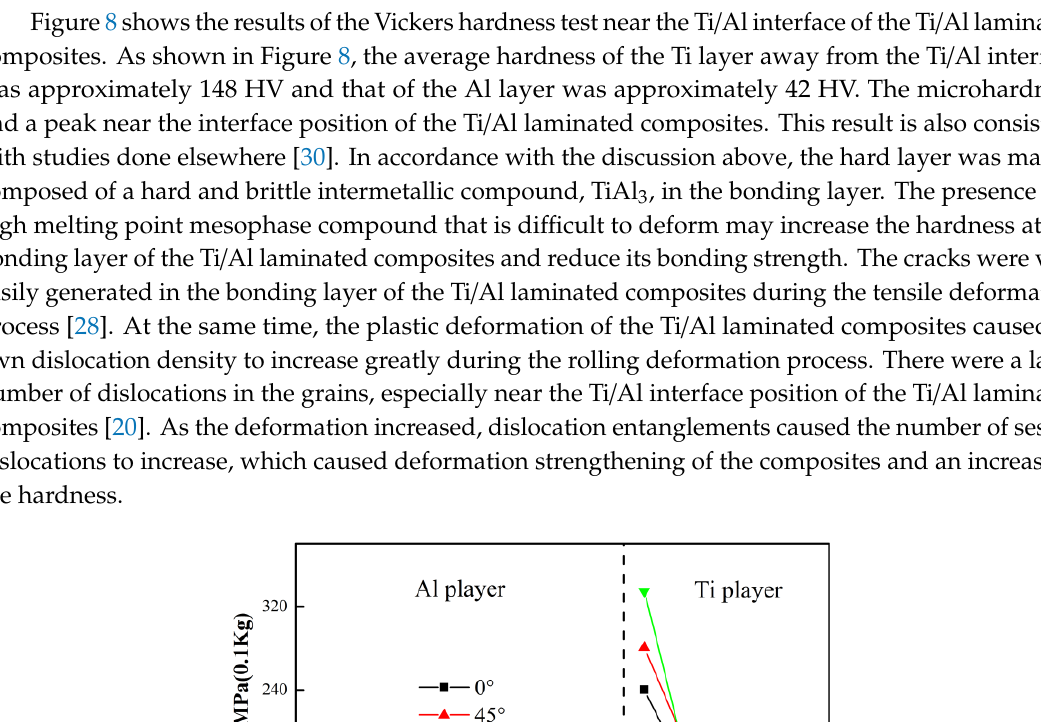
Figure 7. Results of the X-ray diffraction (XRD) test in the bonding layer of the Ti/Al laminated composites.